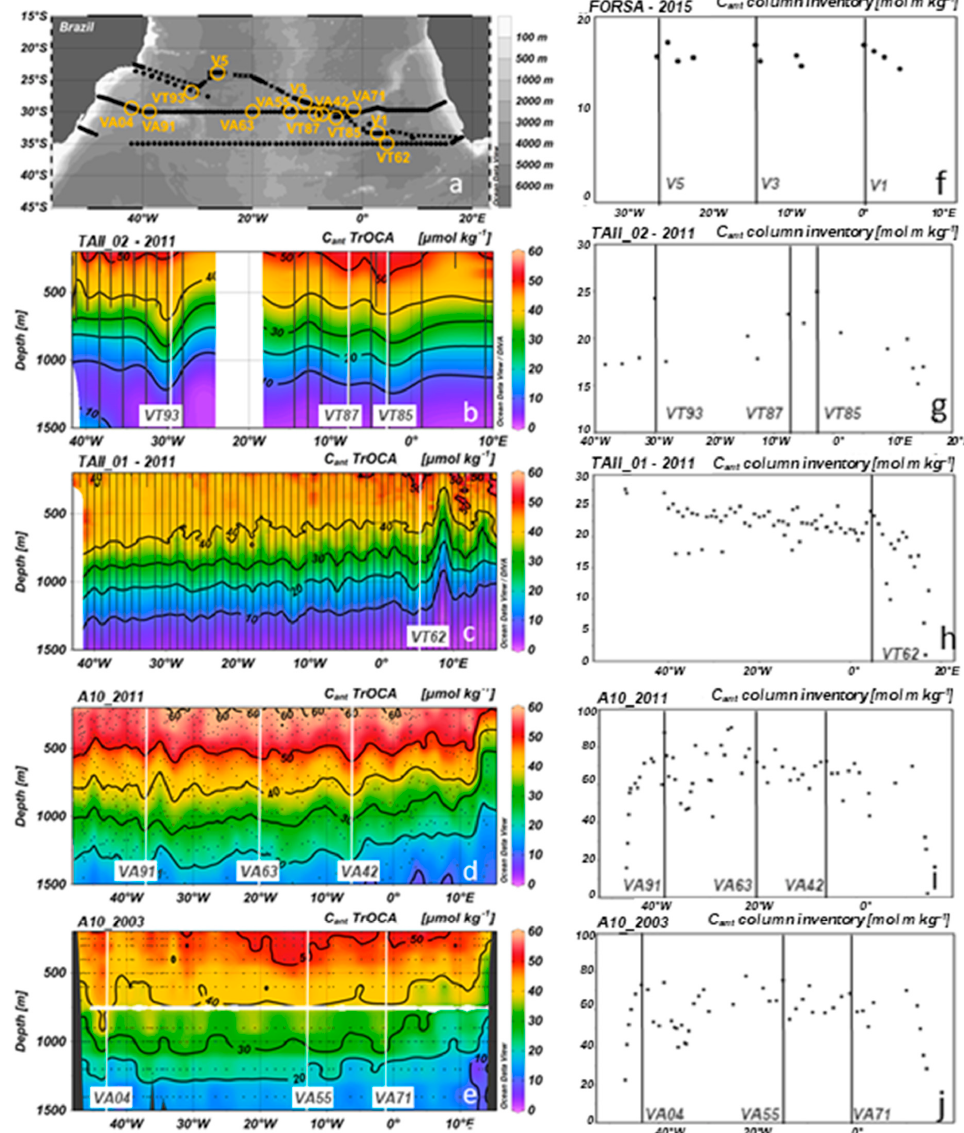
Figure 6. ( a ) Map of the cruise sections and sampled eddies. For a complete description of this map, please see Figure 1. ( b – e ) anthropogenic carbon (C ant-TrOCA µ mol kg − 1 ) content along the cruise sections: ( b ) TAII_02-2011 section, ( c ) TAII_01–2011 section, ( d ) A10_2011 section, ( e ) A10_2003 section. The continuous gray lines or gray dots indicate the position of CTD stations. The sampled eddies are indicated by a continuous white line; ( f – j ) anthropogenic carbon (C ant-TrOCA mol m kg − 1 ) inventory along the water column; ( f ) FORSA–2015 section, ( g ) TAII_02-2011 section, ( h ) TAII_01-2011 section, ( i ) A10_2011 section, ( j ) A10_2003 section. The column inventory was determined by integrating the C ant from 200 m to 500 m for the FORSA cruise and from 200 m to 1500 m for the other cruises. The sampled eddies are indicated by a continuous black